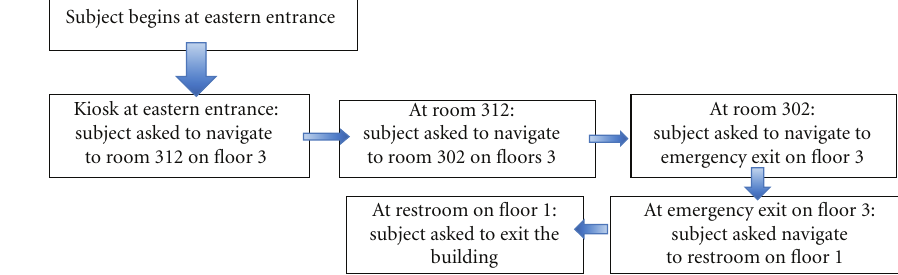
Figure 9: Test scenario in Phase II trials.